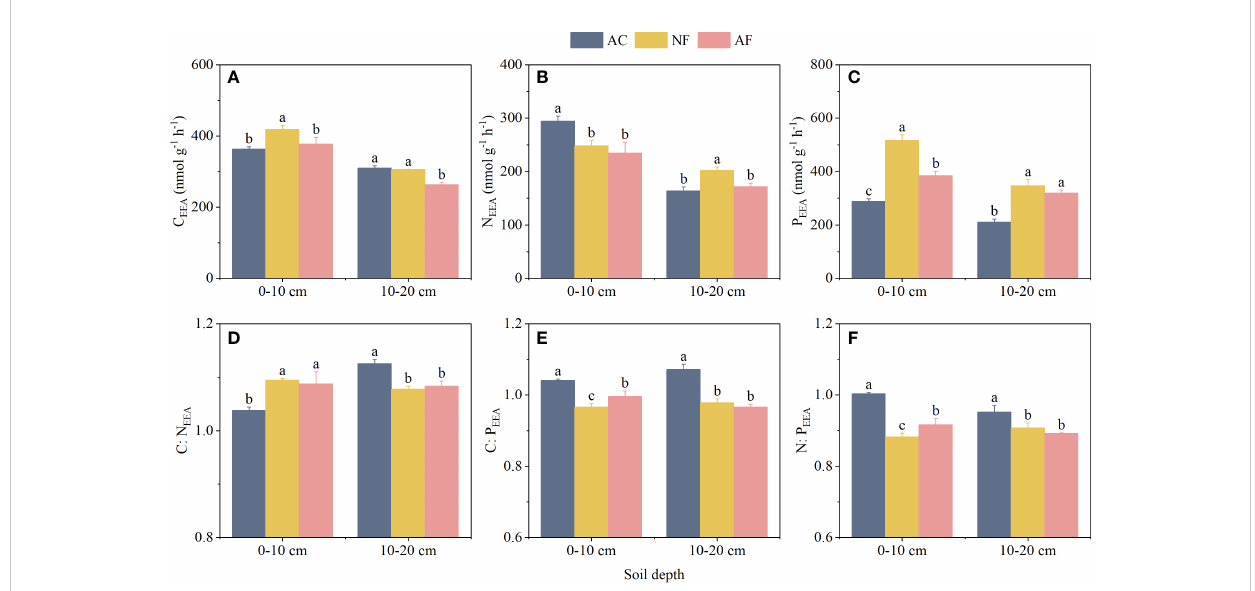
FIGURE 1 Effect of vegetation restoration on soil EEA and EES in abandoned cropland. (A) C EEA ; (B) N EEA ; (C) P EEA ; (D) C EEA : N EEA ; (E) C EEA : P EEA ; (F) N EEA : P EEA . AC, abandoned cropland; NF, naturally restored secondary forest; AF, arti fi cial planted forest; CEEA, the sum of b -1,4-glucosidase, b - Dcellobiohydrolase and xylosidase; NEEA, the sum of b -N-acetylglucosaminidase and leucine aminopeptidase; PEEA, alkaline phosphatase. Different lowercase letters indicated signi fi cant differences between vegetation restoration types (LSD, P < 0.05).